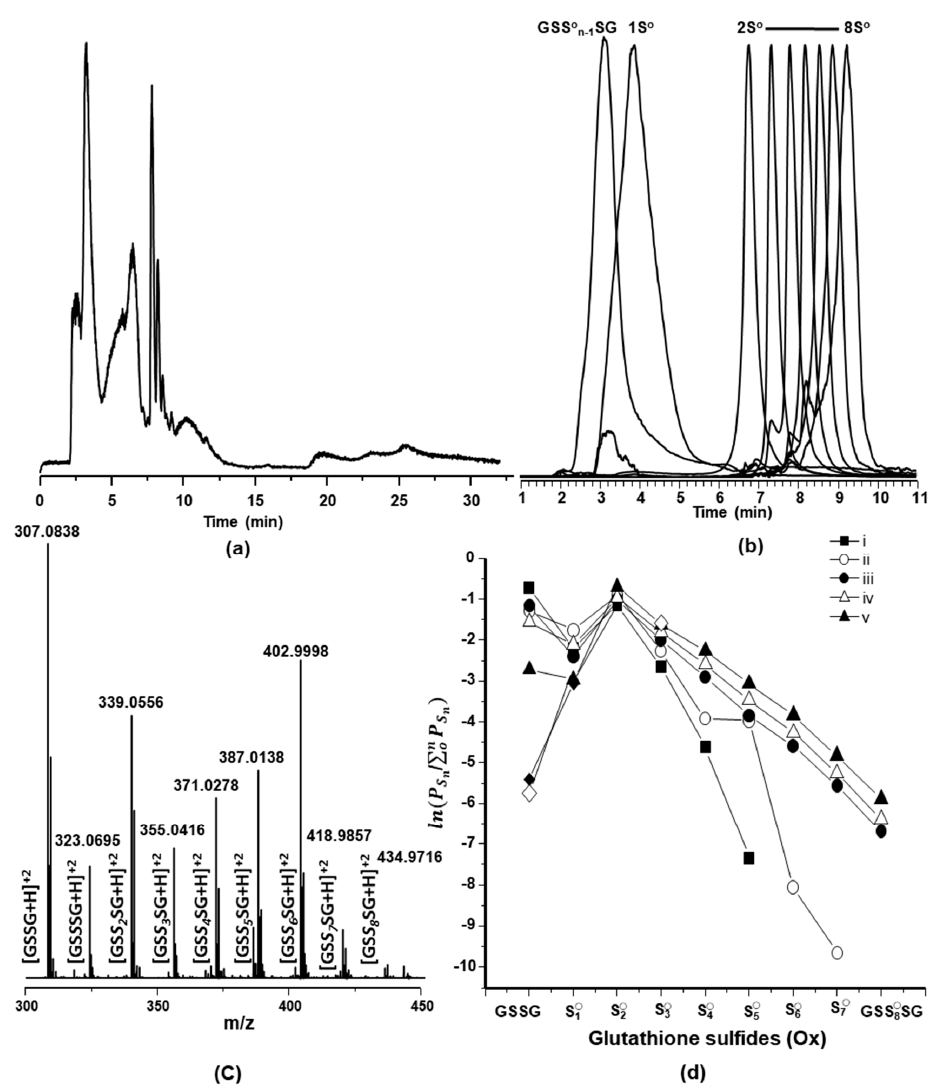
Figure 1. Liquid chromatography-high resolution mass spectrometry ( LC-HRMS) analysis of oxidized glutathione polysulfane species formed in a 1:5 reaction of GSNO with Na 2 S at pH 7, with 0.1% formic acid-acetonitrile as a carrier stream. ( a ) The total ion LC spectra. ( b ) Normalized selective ion chromatograms (SICs) showing a series of GSS n SG polysulfanes, n = 0–8, and the separation times of each within the overall LC spectra. ( c ) Region of the total ion mass spectra showing peaks assigned as shown, to dications. ( d ) Logarithmic representations of speciation concentrations calculated from the peak area of the respective species in the LC-HRMS spectral analysis of oxidized glutathione polysulfanes in the reaction of one equivalent of GSNO with increasing equivalents of Na 2 S under aerobic condition: (i) 0.25, (ii) 0.5, (iii) 1, (iv) 2.5 and (v) 5 equivalents of Na 2